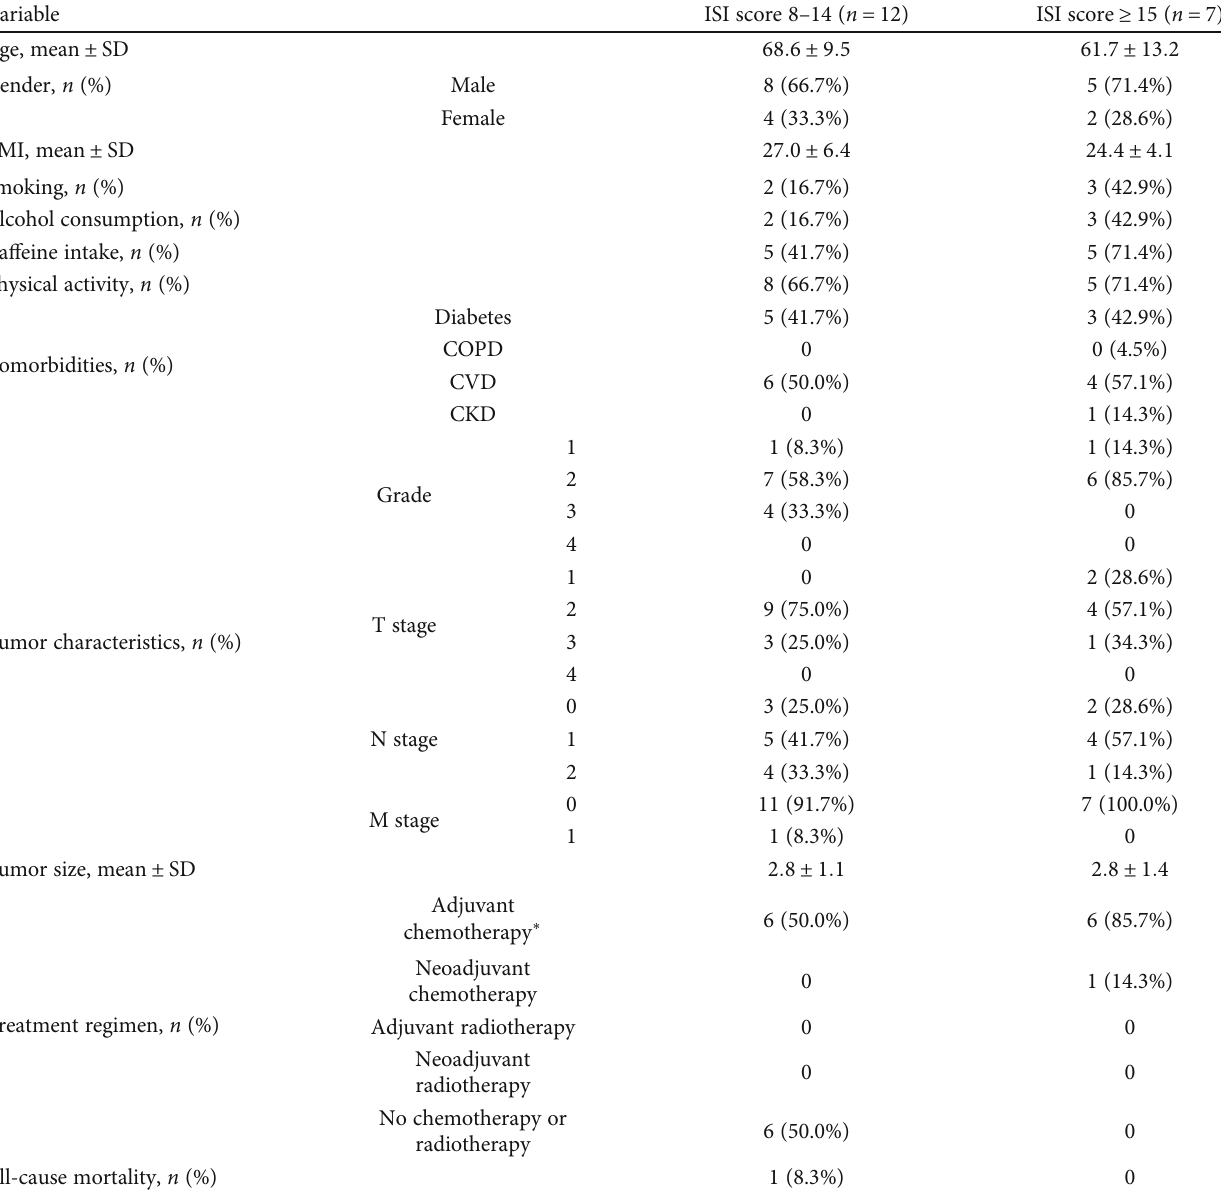
Table 3: Prevalence of mild insomnia and moderate to severe insomnia in patients